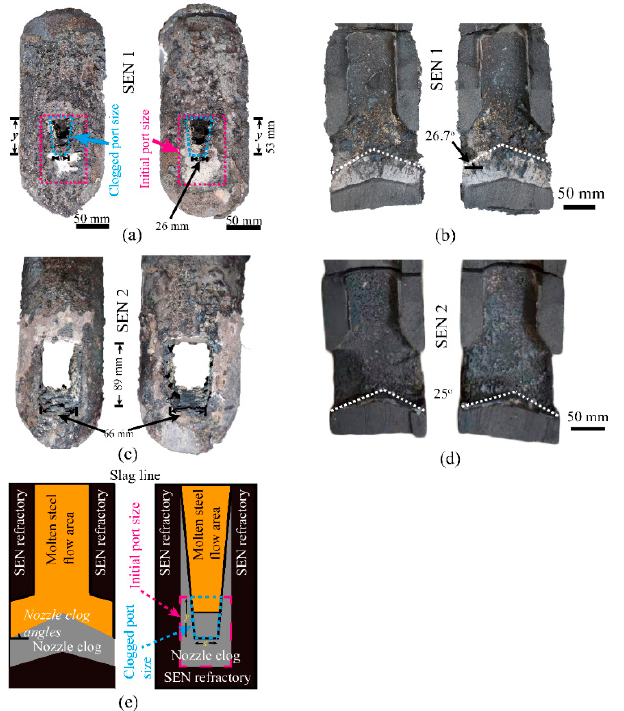
Figure 2. The typical morphologies of offline submerged entry nozzles (SENs), ( a ) SEN1 ports, ( b ) the dissection of the SEN1 bottom, ( c ) SEN2 ports, ( d ) the dissection of the SEN2 bottom, ( e ) schematic of the SEN clog geometry model.